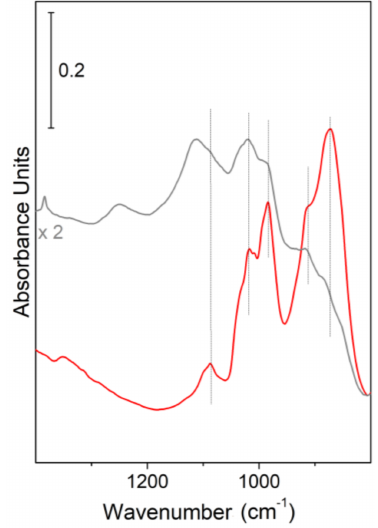
Figure 2. Fourier-transform Infrared spectra of Kadox ZnO (red line) and ZnO nanostructured microcages (grey line) samples background in the lattice modes